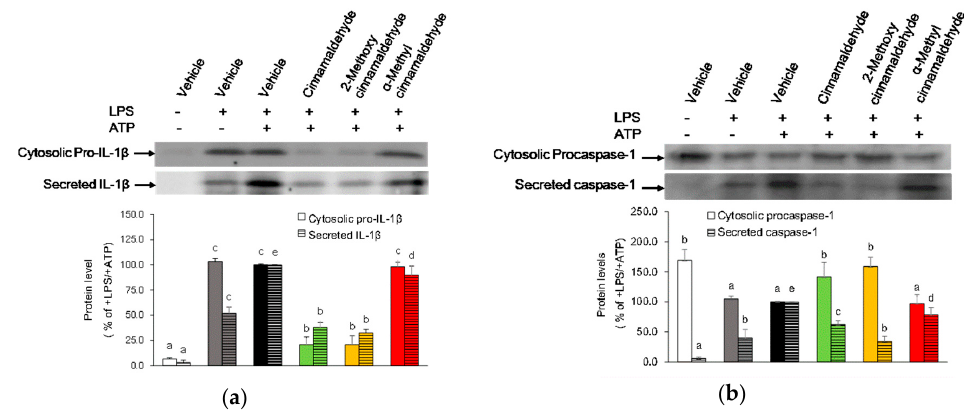
Figure 6. Influence of cinnamaldehyde-related compounds on the secreted protein levels of IL-1 β ( a ) and caspase-1 ( b ) from LPS-primed and ATP-activated macrophages. The macrophages were pretreated with 100 μ M cinnamaldehyde-related compounds for 30 min and then treated with LPS and ATP. Medium proteins were collected to measure protein levels of IL-1 β and caspase-1 by Western blot. Data are expressed as the mean ± SD and different superscript letters presented statistical difference ( p < 0.05).